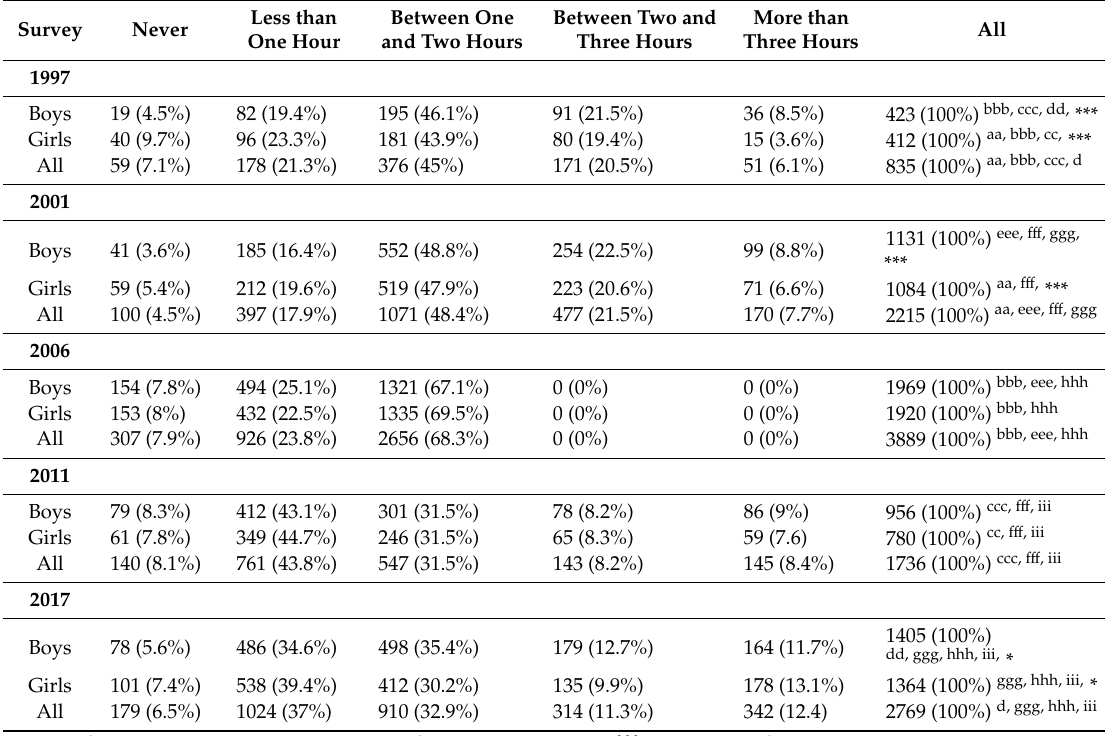
Table 3. Hours of watching television daily ( n